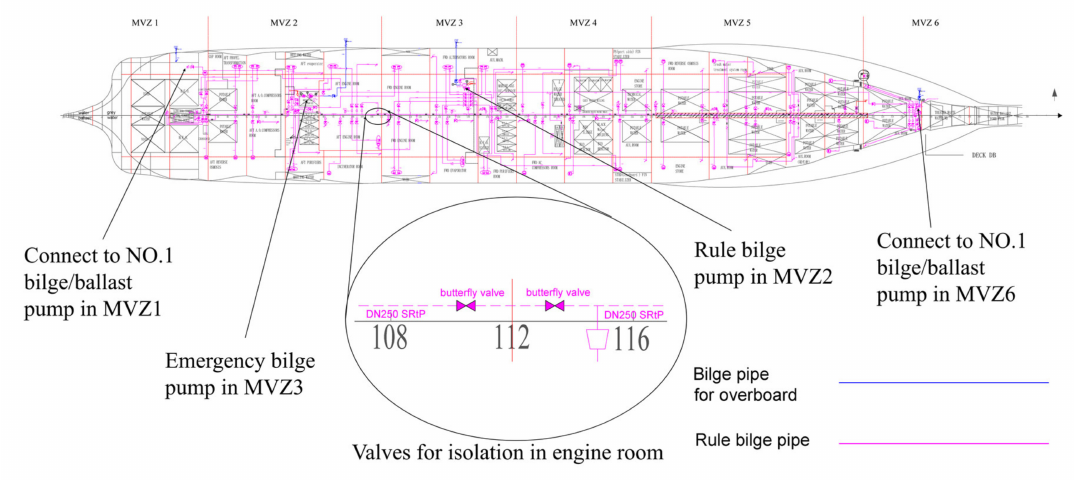
Figure 7. Rule bilge system.